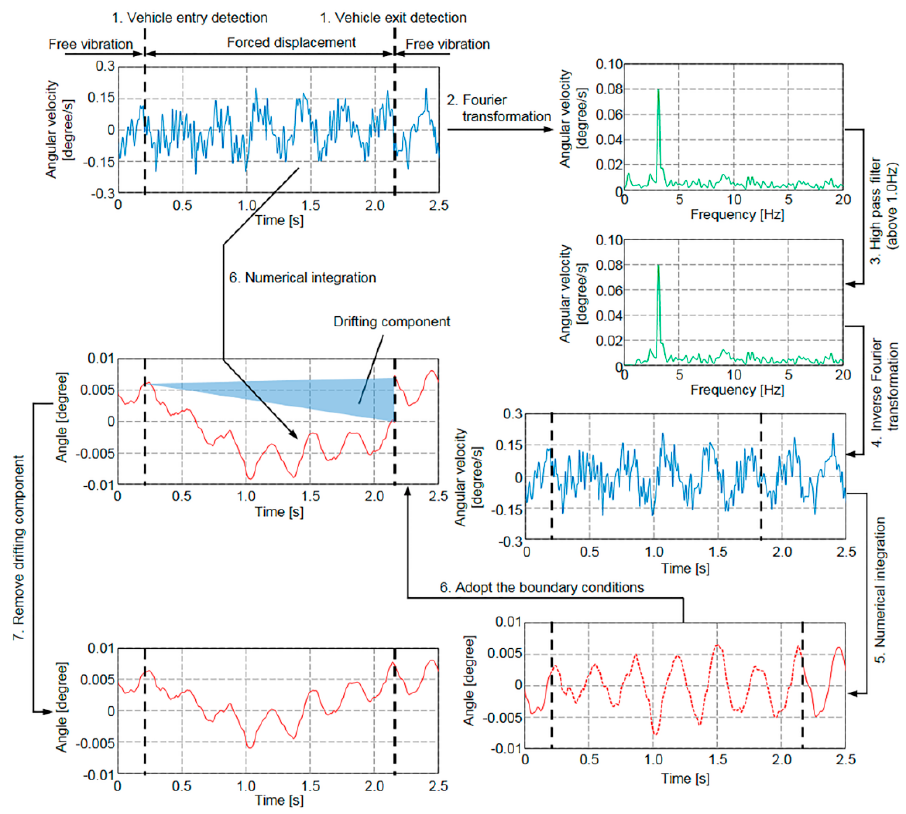
Figure 10. Procedure used in the proposed method to determine bridge rotation angle from measured angular velocity.